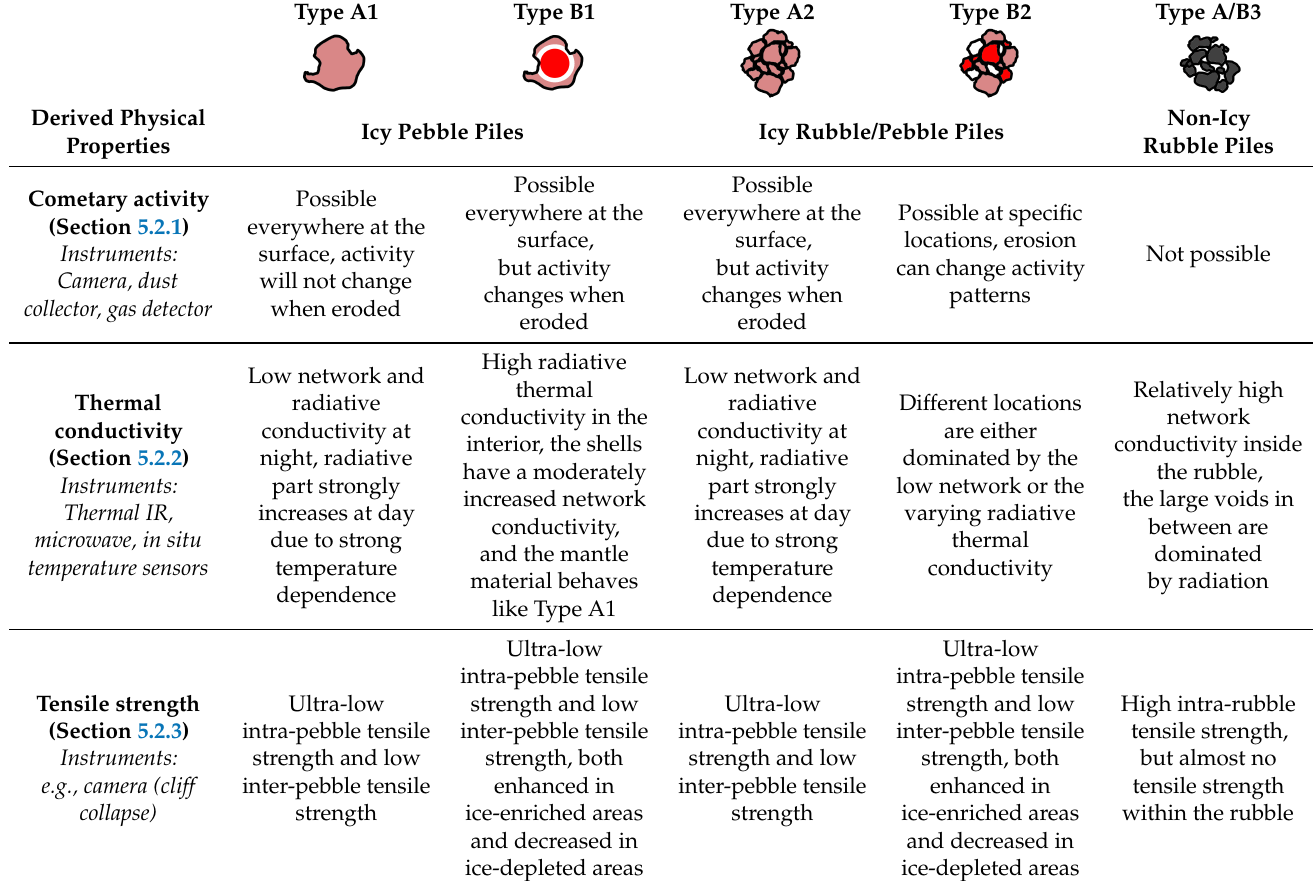
Table 2. Overview of the different proposed types of objects with their expected derived physical properties, which are discussed in detail in the following